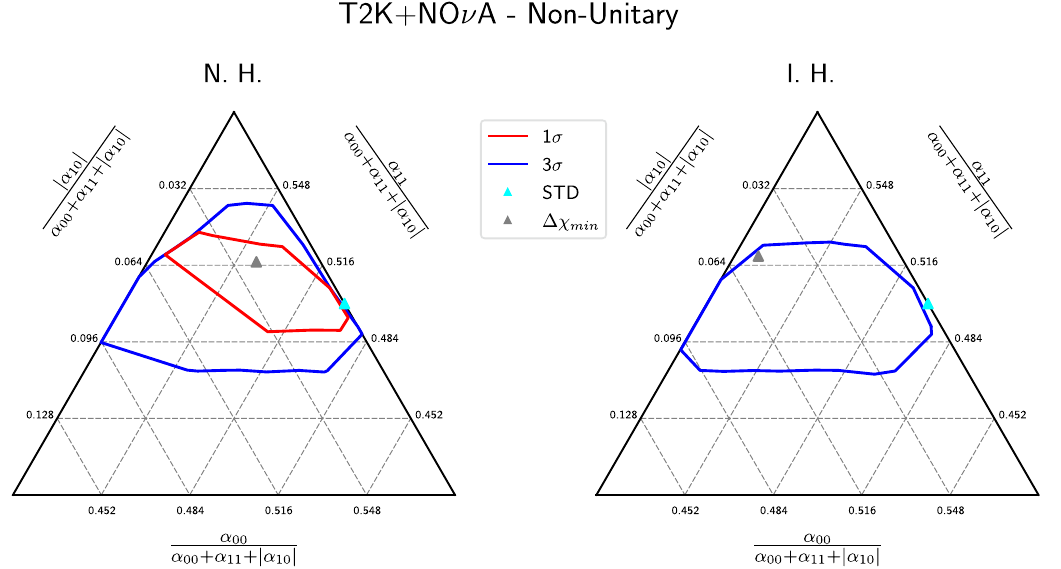
Fig. 14 Allowed regions of the α parameters in a triangular plot for the combined analysis. The left (right) panel is for NH (IH). The parameter values at the best-fit point have been mentioned in Table 3. These results are for 2019 data